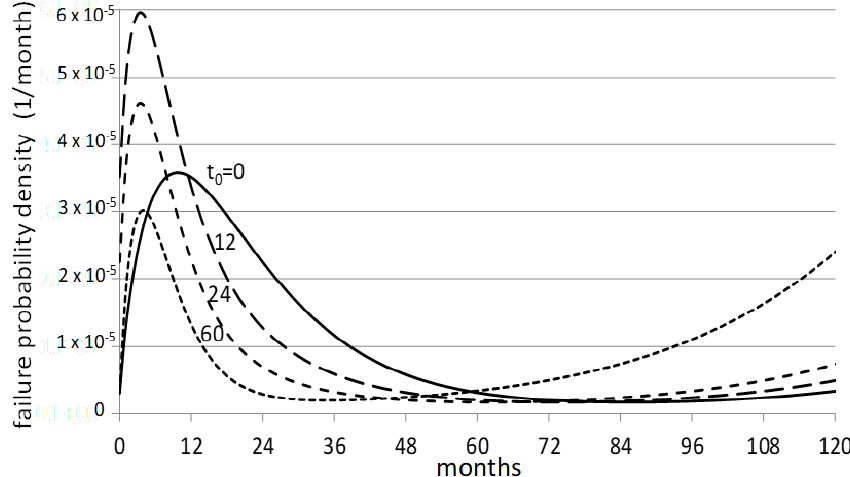
Figure 13. Failure probability density function f R ( t , t 0 ) of used microcontrollers as a function of time for di ff erent values of t 0 (the life of the component before it is mounted on a new device).